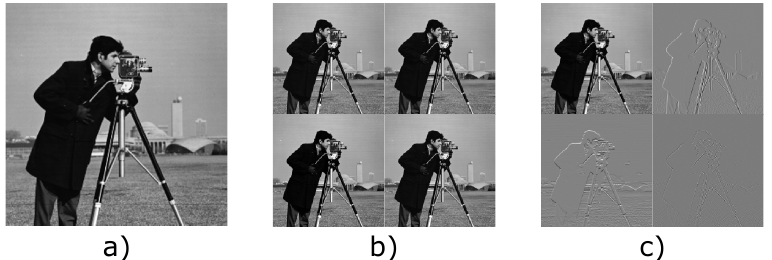
Figure 1. Input image ( a ) and output of checkerboard downsampling ( b ) and haar downsampling ( c ). Inspired by